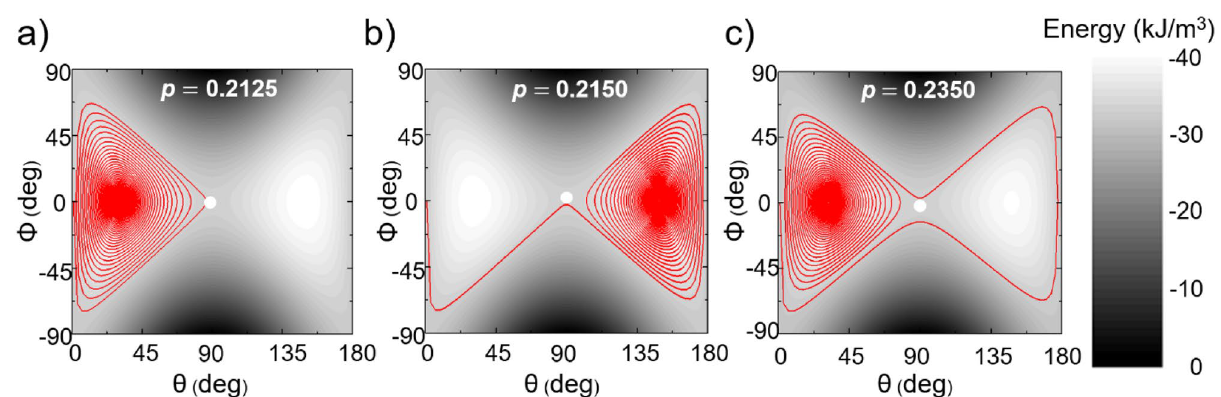
Figure 3. Magnetization dynamics for below critical ( p = 0.2125), at critical ( p = p c = 0.2150) and above critical MCA modulation ( p = 0.2350), for µ 0 H ip = 0.0324 T and α = 0.01. The trajectories are described in terms of standard polar and θ angles. The pulse duration is T p = 10 ϕ